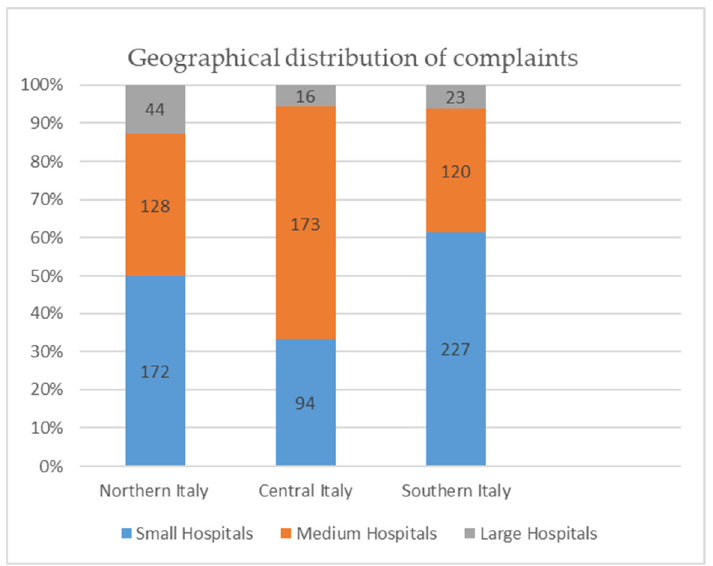
Figure 2. Geographical distribution of complaints.